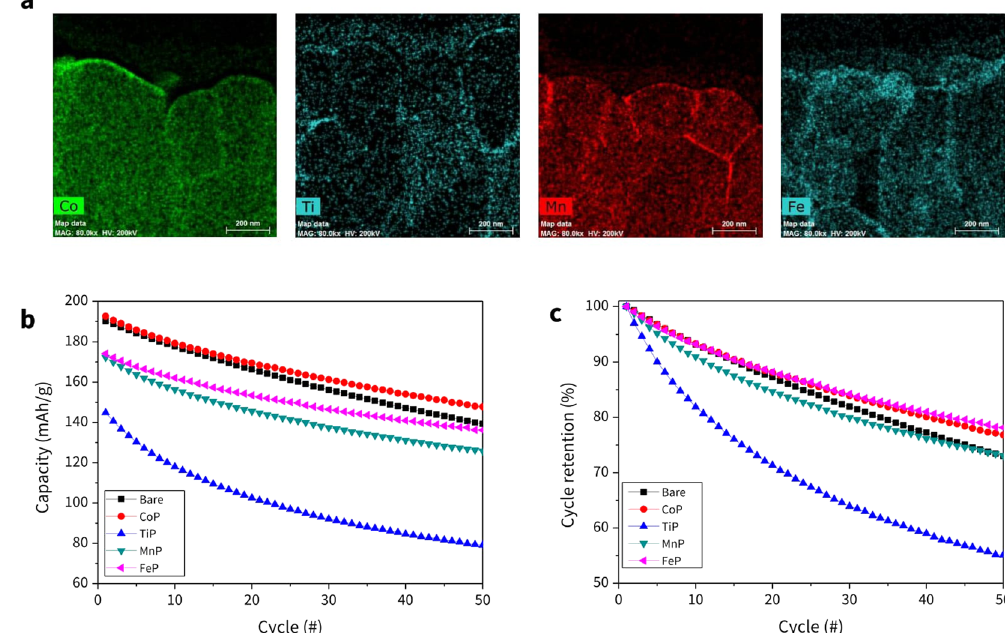
Figure 4. ( a ) EDS elemental mapping of corresponding metal element for Co-, Ti-, Mn-, and Fe-P. ( c ) The variation of the initial capacity and ( d ) the capacity retention rate during 50 cycles for NCM and NCM coated with Co-, Ti-, Mn-, and Fe-P.